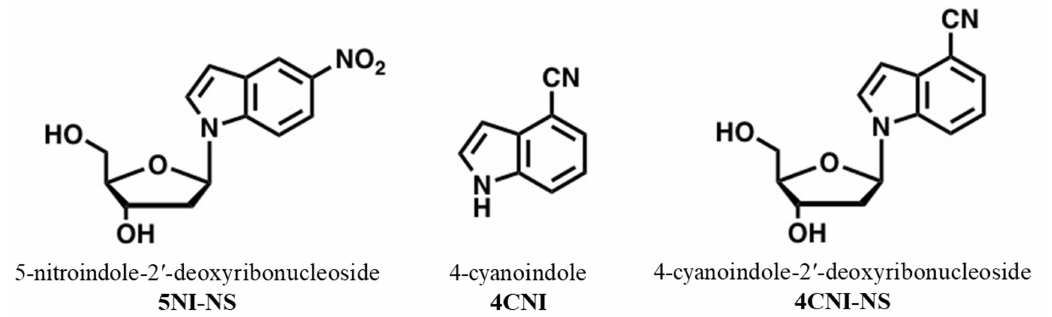
Figure 1. Structures of 5-nitroindole-2 (cid:48) -deoxyribonucleoside (5NI-NS), 4-cyanoindole (4CNI) and 4-cyanoindole-2 (cid:48) -deoxyribonucleoside